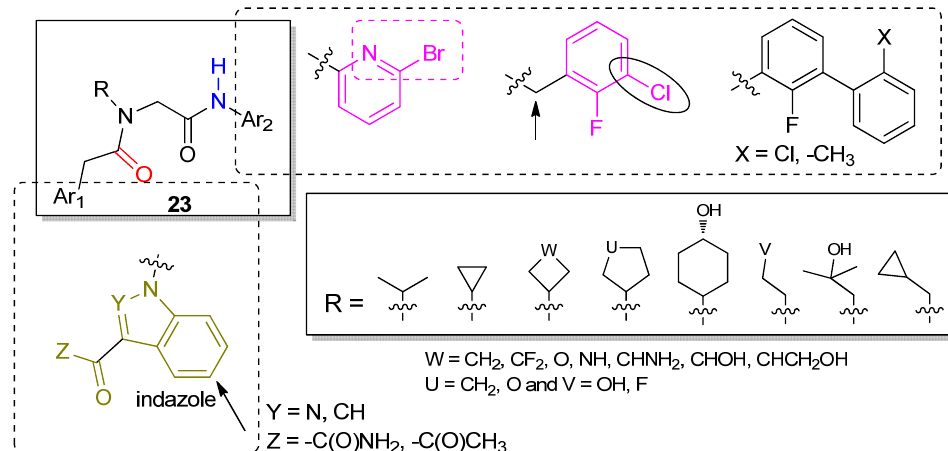
Figure 11. N-Substituted glycine-based FD inhibitors with affinity for the locked (latent) enzyme